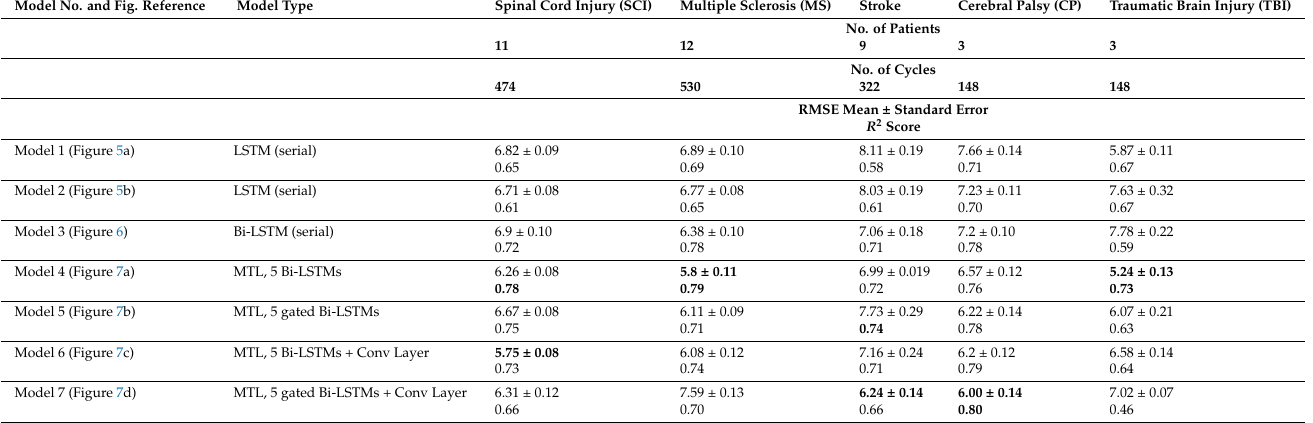
Table 4. Performance of different models in prediction of post-treatment gait trajectories with respect to different